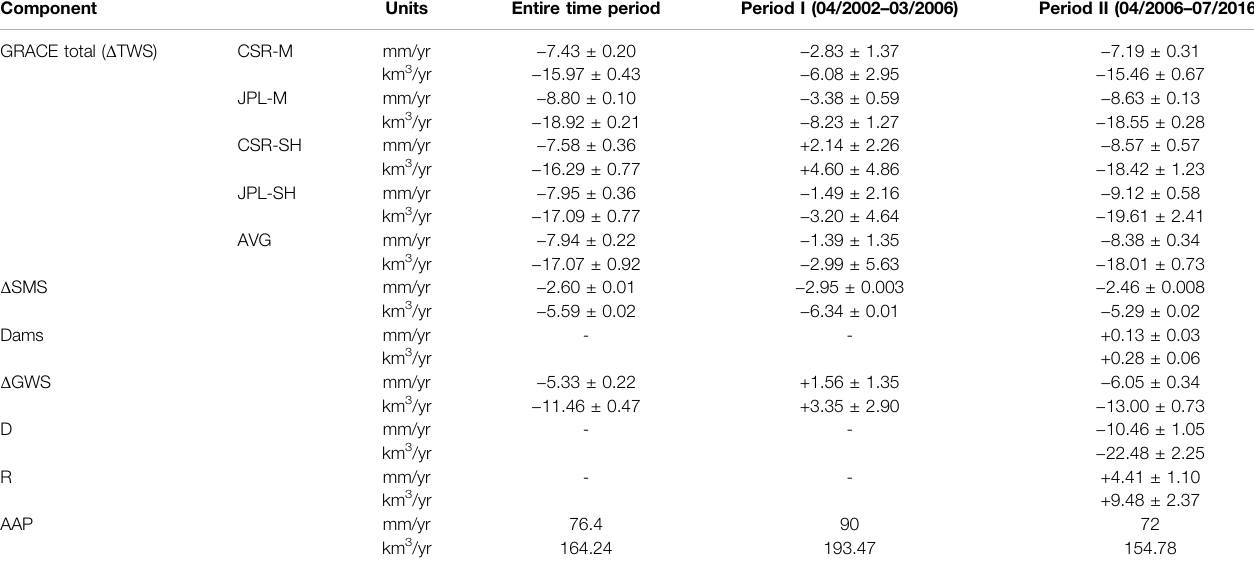
TABLE 1 | GRACE-estimated Δ TWS components over Saudi Arabia. Component